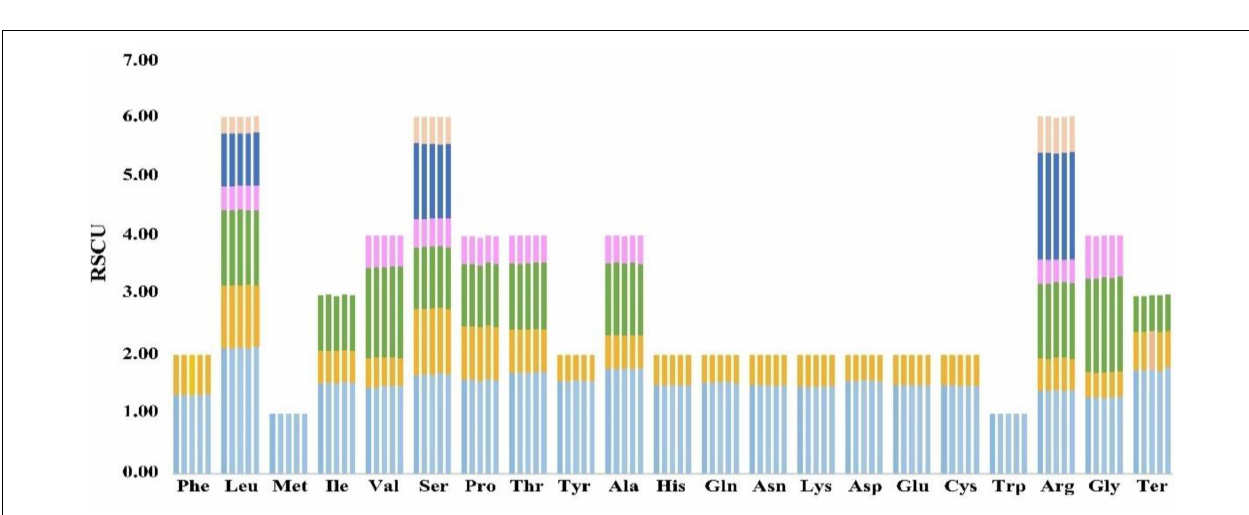
FIGURE 6 | Comparative analysis plots of RSCU values for the five species. Each amino acid corresponds to five histograms, and their heights represent the RSCU value. The histogram from left to right is Coleanthus subtilis , Phippsia algida , Puccinellia nuttalliana , Sclerochloa dura , and Zingeria biebersteiniana